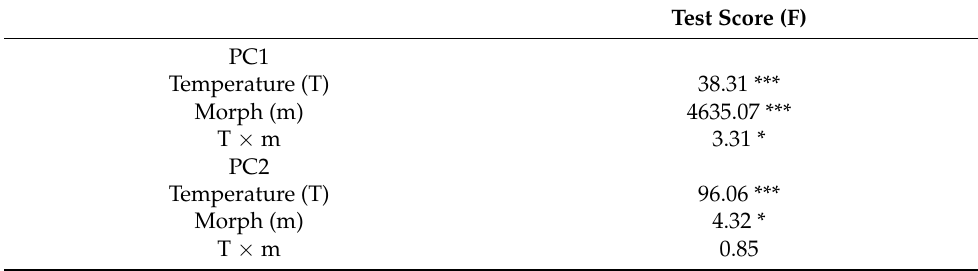
Figure 2. Schematic diagram of the main changes in aphid’s enzyme activity in response to course of development and temperature. G1, G2 and G3 groups of enzymes: antioxidant, detoxifying and oxidoreductive, respectively. Enzyme activity responses were ranked based on Spearman’s rho correlation coefficients given in Table 3. Correlation coefficients with values indicating at least an average correlation (0.3 ≤ rho ) were taken into consideration. See Table 3 for detailed results. Table 2. ANOVA test results confirm that the first component (PC1) mainly shows that the strong dif- ferentiation of aphid enzymatic response depends on developmental stage (type of morph: nymphs, adults), and the second component (PC2) mainly shows that the differentiation of aphid enzymatic response depends on